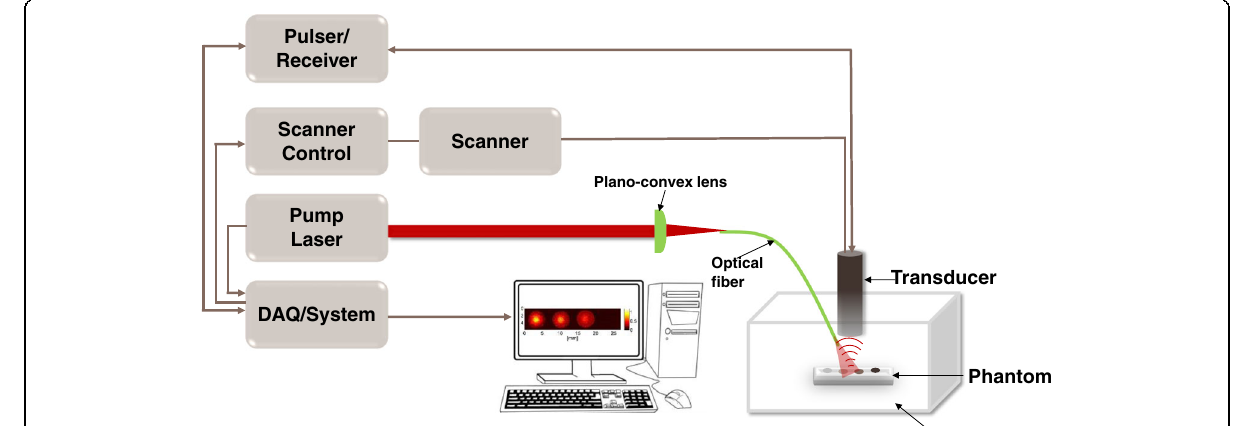
Fig. 11 Experimental setup of PAI system